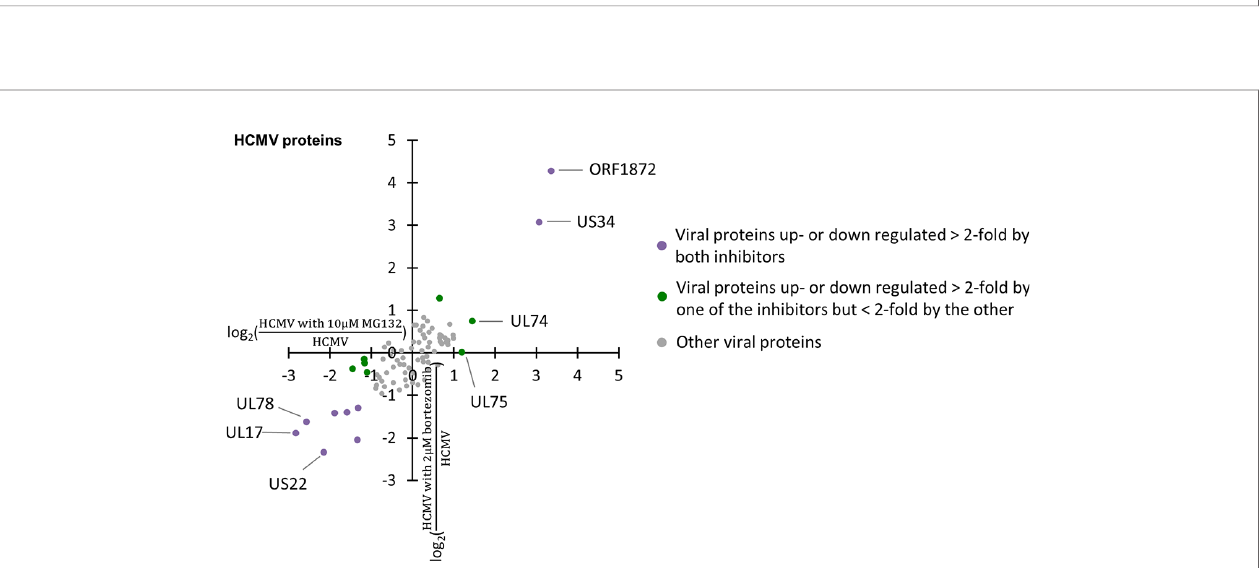
FIGURE 4 | Regulation of 82 viral proteins by proteasome inhibitors. Viral proteins up- or down-regulated >2-fold by both proteasome inhibitors are marked in purple, with proteins up- or down-regulated >2-fold by one proteasome inhibitor, but <2-fold by the other inhibitor marked in